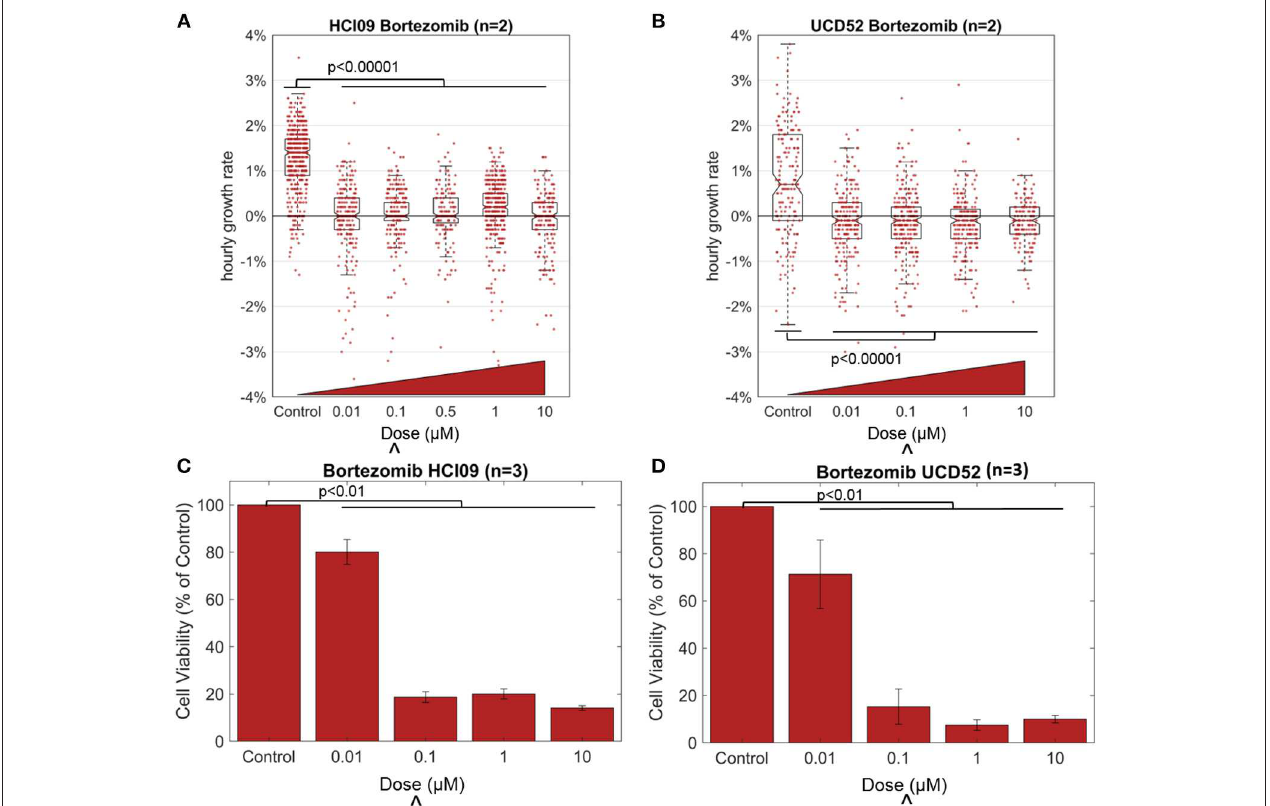
FIGURE 2 | Effect of the proteasome inhibitor bortezomib in TNBC PDXs HCI09 and UCD52, measured by HSLCI (A,B) and standard luciferase assays (C,D) . Individual dots in the overlaying the box plot represent the mass accumulation rates of single cells measured over the interval 24–40h post-dosing. Box-plot notches are indicative of 95% confidence intervals for the medians. The “ ∧ ” symbol indicates the in vitro dose that corresponds to the maximum tolerated serum concentration in humans [18]. In HSLCI experiments, the data shown was pooled from two replicates. In (C,D) , error bars represent standard deviation. Two sample t -tests were performed between all populations compared to the control